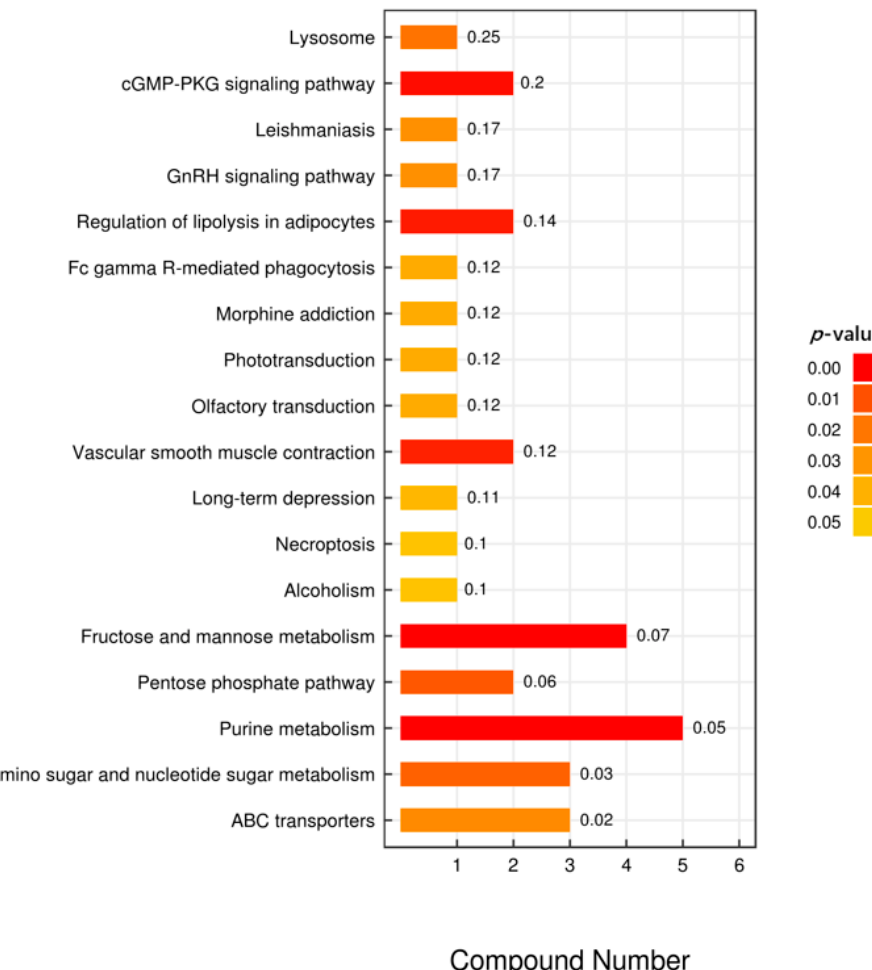
Figure 4. KEGG analysis of intermetabolites. In the bar chart, the vertical axis represents each KEGG metabolic pathway, while the horizontal axis represents the number of differential metabolites contained in each KEGG metabolic pathway and the numbers in front of horizontal bars represent the ratio of differential metabolites to total metabolites. The color represents the p -value of the enrichment analysis. The darker the color, the smaller the p -value, and the more statistically significant.